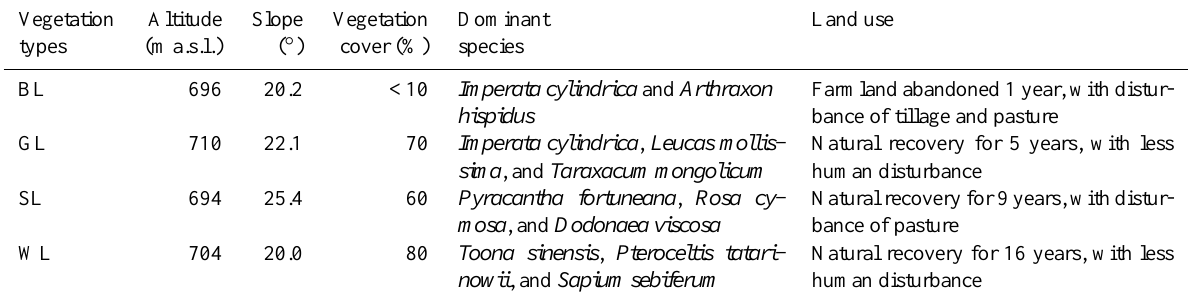
Table 1. Basic properties of study plots. Vegetation Altitude Slope Vegetation Dominant Land use types